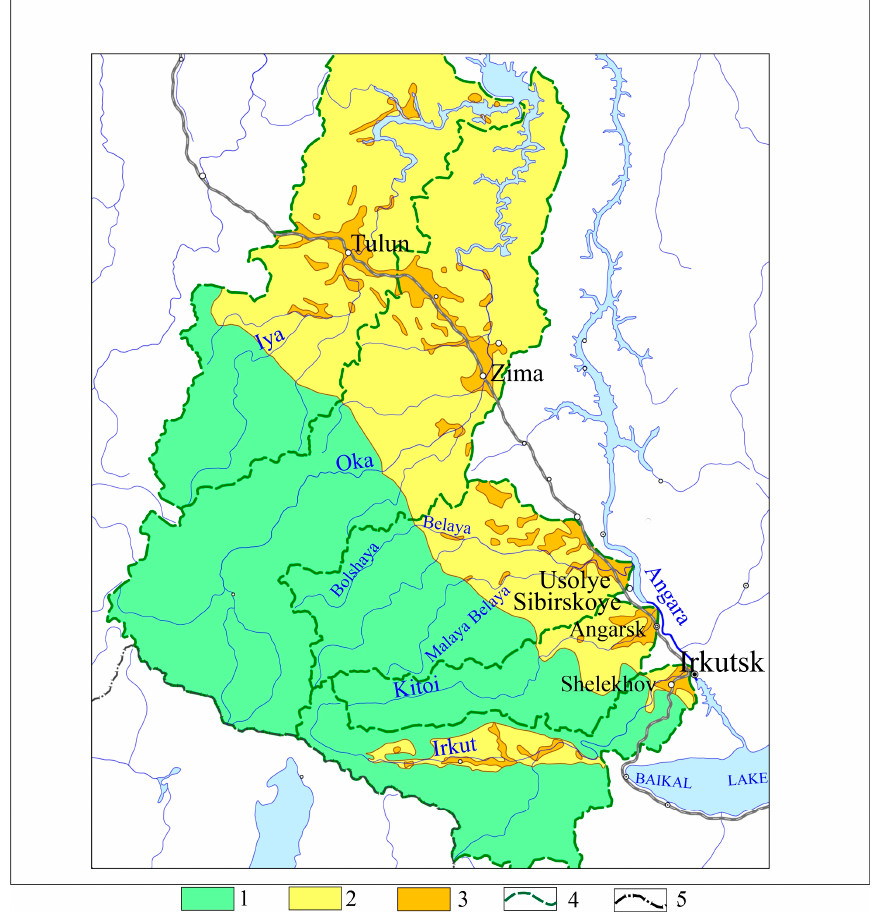
Figure 11. Zoning of floodplain–channel complexes along the rivers of the Upper Angara region and adjacent territories according to the degree of development dynamics. Legend: 1—dynamically-developing floodplain–river complexes; 2—relatively stable floodplain–river complexes; 3—relatively dynamically-developing floodplain–river complexes of anthropogenically-disturbed territories; 4—state borders; 5—basin boundaries.